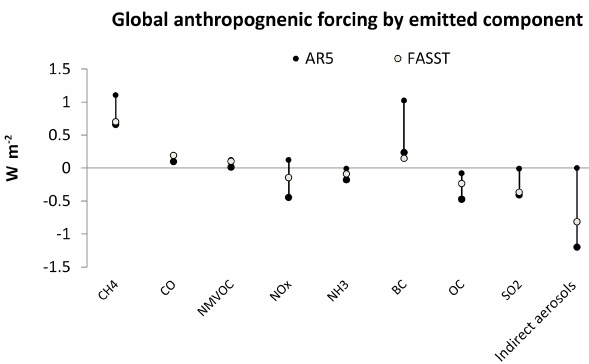
Figure 14. Global anthropogenic radiative forcing by emitted com- ponent, from TM5-FASST forcing efficiencies applied to RCP (year 2000 anthropogenic emissions), and range of best anthro- pogenic forcings from AR5 (change over the period of 1750–2011).